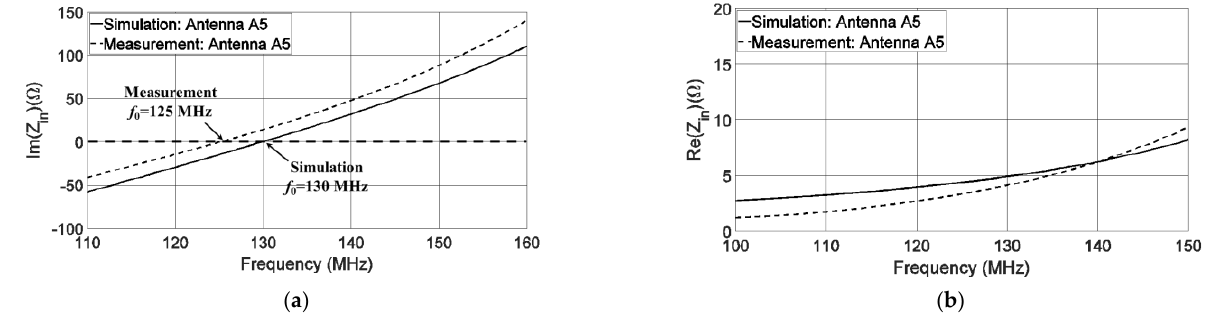
Figure 12. Imaginary ( a ) and real ( b ) parts of the measured and simulated input impedance of the antenna A5.